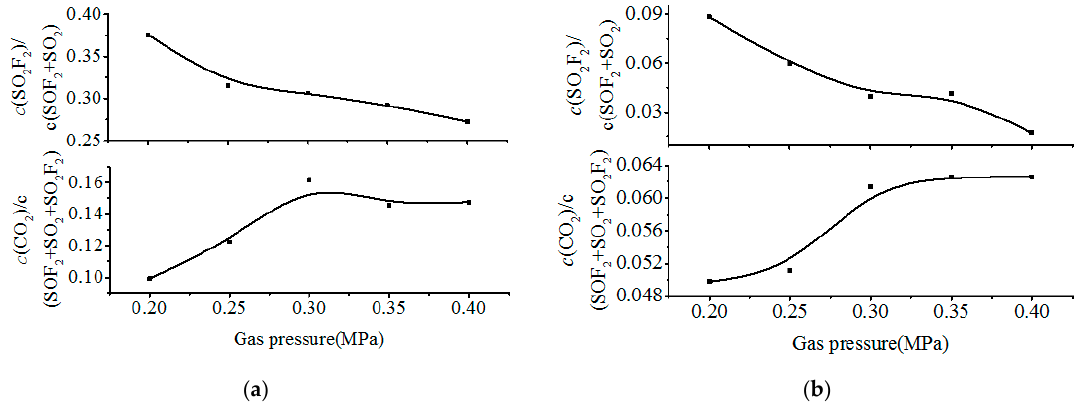
Figure 8. Correlation curve of effective concentration ratios of characteristic component versus gas pressure: ( a ) Protrusion and ( b ) particles.